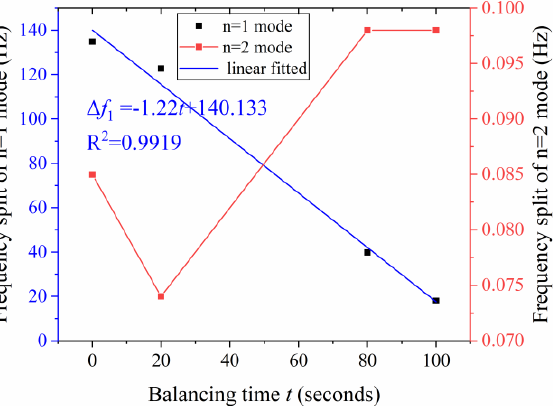
Figure 12. Variations of frequency split of the n = 1 mode and the n = 2 mode during the three rounds chemical balancing on resonator R01.